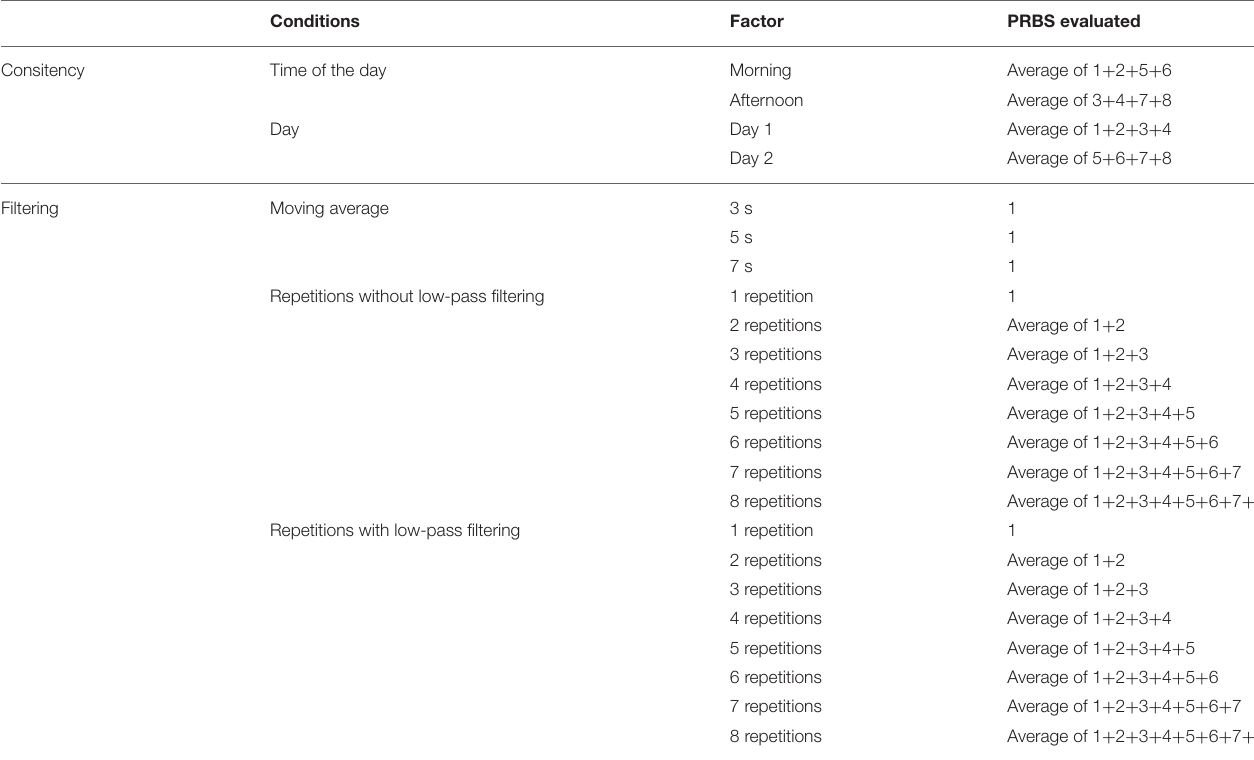
TABLE 1 | Description of the pseudorandom binary sequence (PRBS) protocols (1–8) used to test the influence of some conditions and data pre-processing over the oxygen uptake